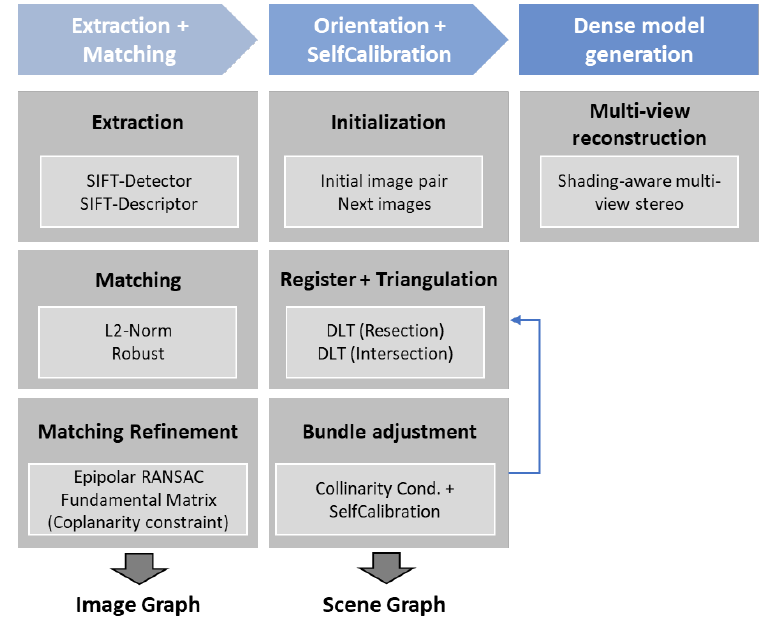
Figure 5. Incremental Structure-from-Motion pipeline developed in GRAPHOS.